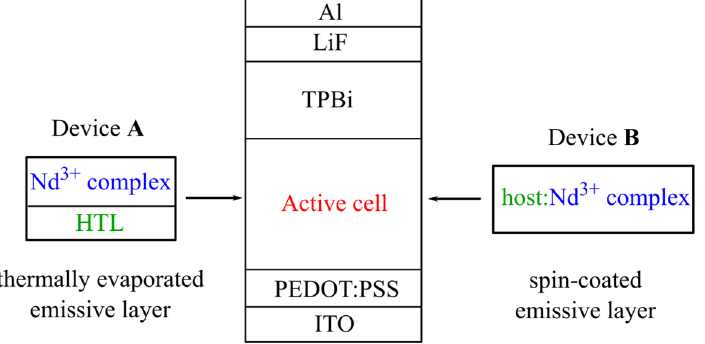
Figure 2. Topology of the OLED devices designed with the Nd1 , Nd2 , and Nd3 complexes as emitters.